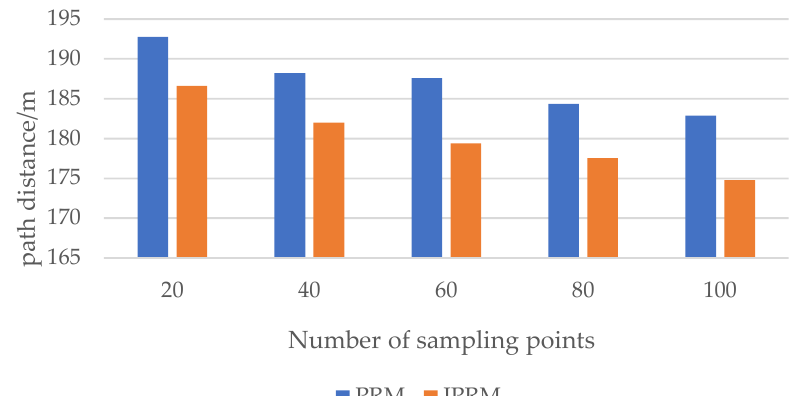
Figure 12. Results for different number of sampling points.